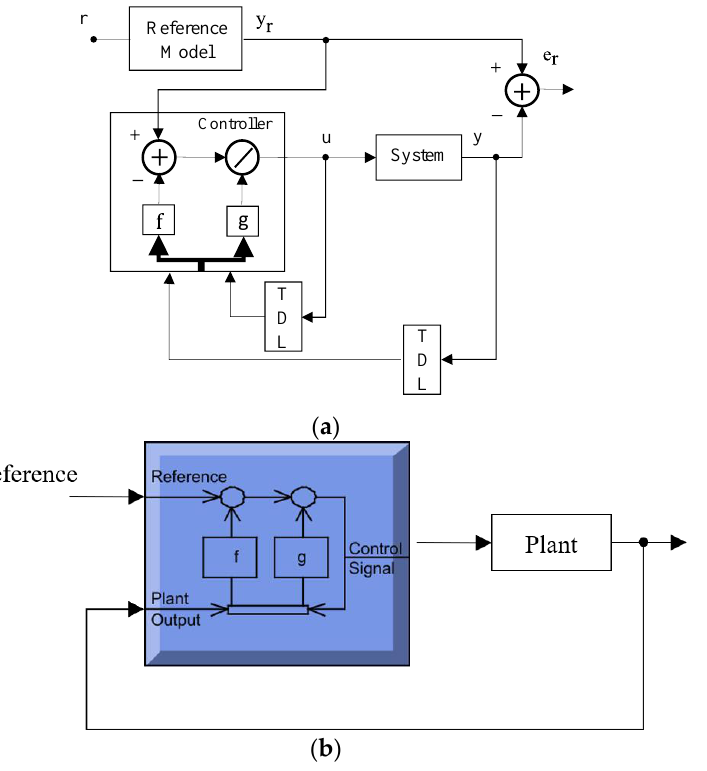
Figure 12. NARMA-L2 architecture. ( a ) Block diagram of the NARMA-L2 controller [49]. ( b ) Block diagram of implementation in Simulink.